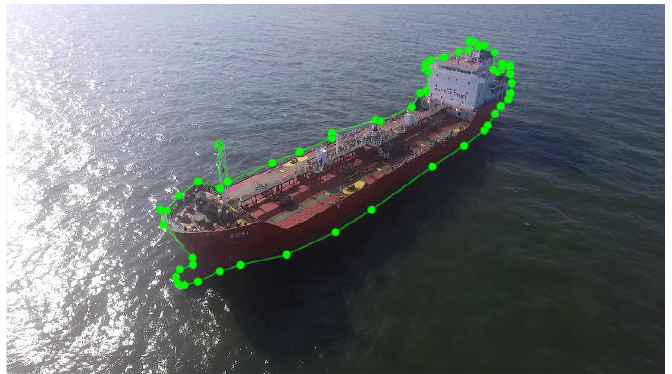
Figure 4. Polygonal Annotation.